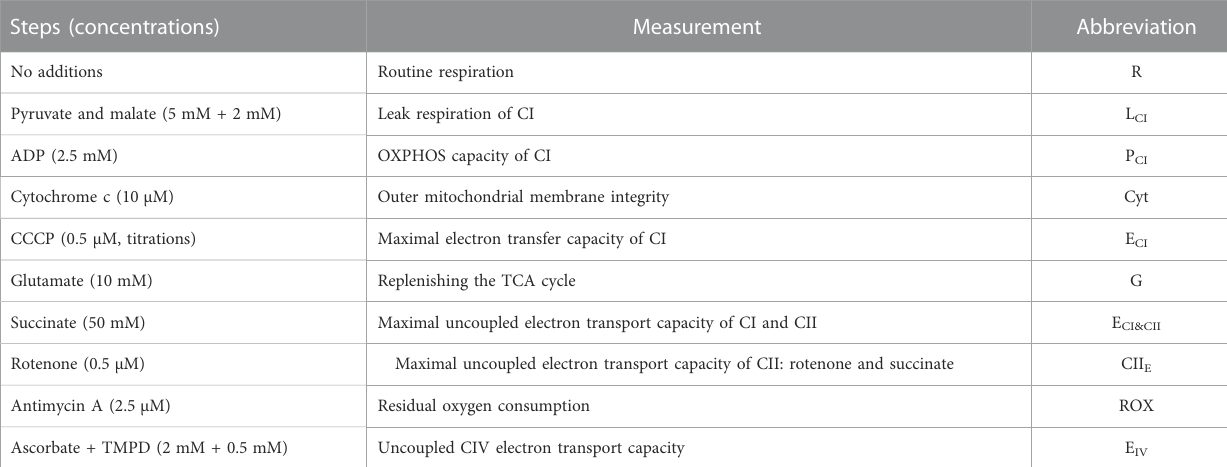
TABLE 1 Substrate — uncoupler — inhibitor titration (SUIT) reference protocol. Steps